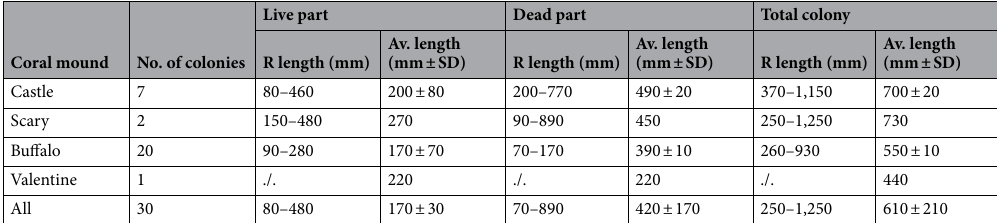
Table 4. Measurements of total length and alive and dead proportions of Madrepora oculata colonies (R: range, Av.: average). For each of the 30 colonies, 3–5 measurements were taken to cover the intra-colonial variability; here the minimum and maximum values (displayed as R length) of all measurements of each colony are provided.